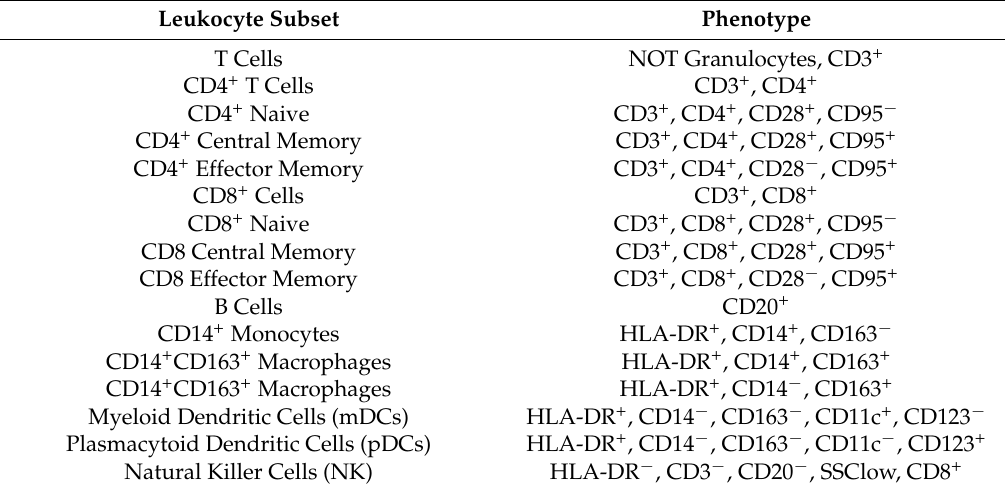
Table 1. Flow cytometry gating